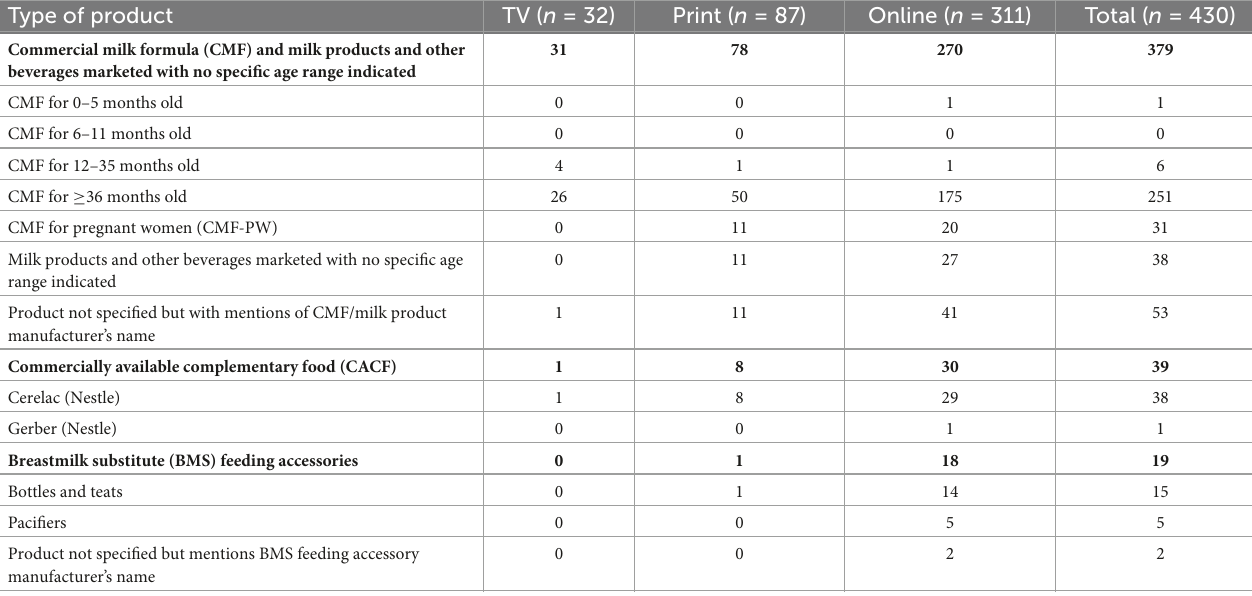
TABLE 2 Number of unique materials by the type of product across multimedia platforms monitored. Type of